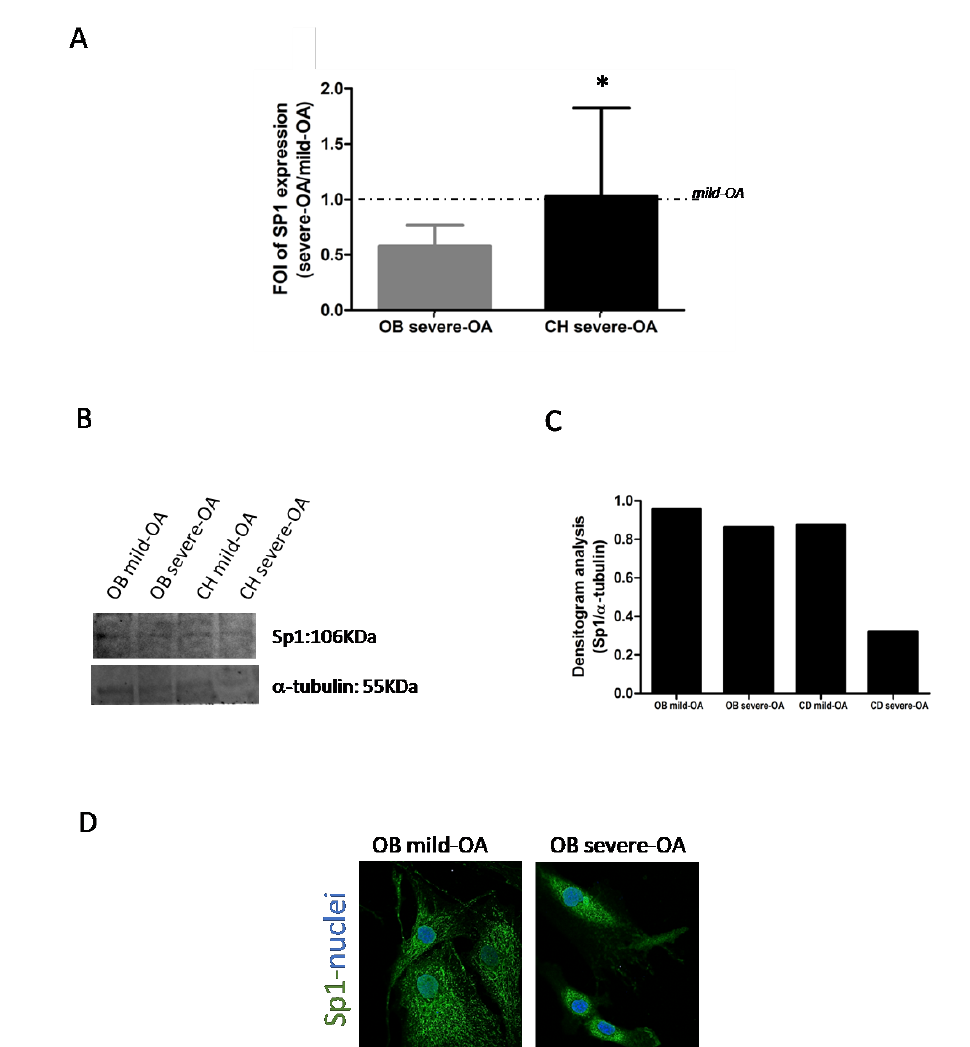
Figure 3. Analysis of SP1 gene and protein expression on osteoblasts (OB) and chondrocytes (CH) derived by patients with mild OA and severe OA. ( A ) qRT-PCR analysis of SP1 gene expression. Data are expressed as fold of change (FOI) in gene expression (2 −ΔΔCt ) occurred in severe OA vs mild OA isolated cells. Data reported were analysed by Student t test: *, p < 0.05, between experimental group and represented as mean ± SD ( n = 4). ( B , C ) Western blot and densitogram analysis of Sp1 and α -tubulin proteins were performed on total cell extract isolate by primary cells derived by mild- and severe OA groups. ( D ) Confocal analysis of Sp1 protein expression and localization on OB isolated by mild OA and severe OA patients. In green the Sp1 signals while in blue the nuclei